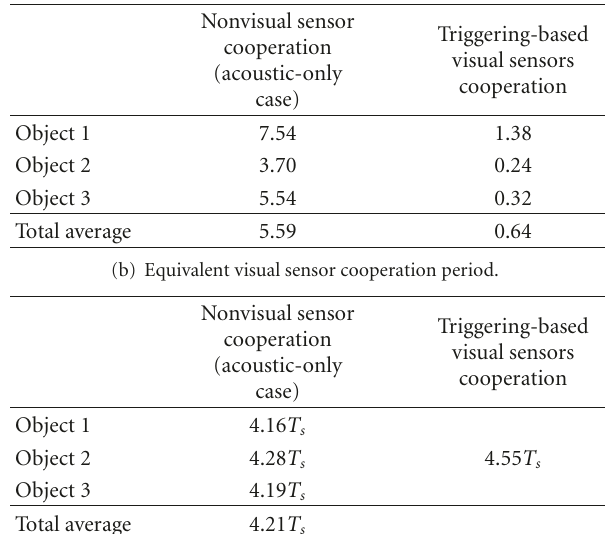
Table 1: Performances of the triggering-based visual sensor coop- eration, the periodic visual sensors cooperation and the nonvisual sensor cooperation (acoustic-only